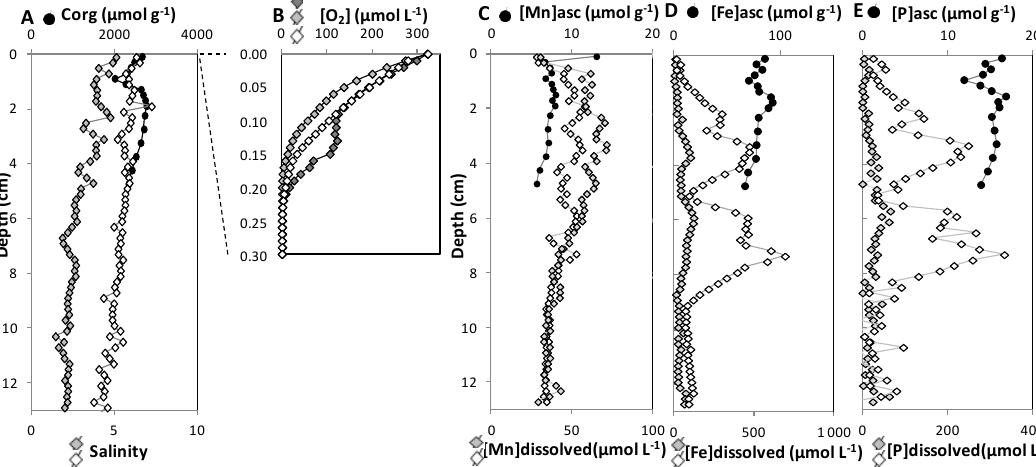
Figure 3. 1-D geochemical features. (a) Vertical profile of total solid organic carbon (filled circles, uncertainty smaller than symbol size) and profiles of salinity (white and grey diamonds). (b) Typical profiles of dissolved oxygen; the profile with dark-grey diamonds is considered bioturbated. (c, d, e) Vertical profiles of manganese (c) , iron (d) and phosphorus (e) in dissolved (white and grey diamonds for DET replicates) and reactive solid phase (ascorbate-leached) from the core (black